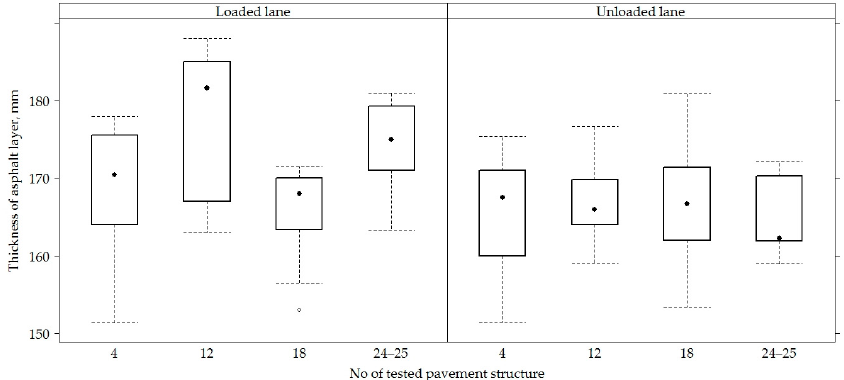
Figure 4. The box-plot of the total thickness of asphalt concrete layers in loaded and unloaded lanes.